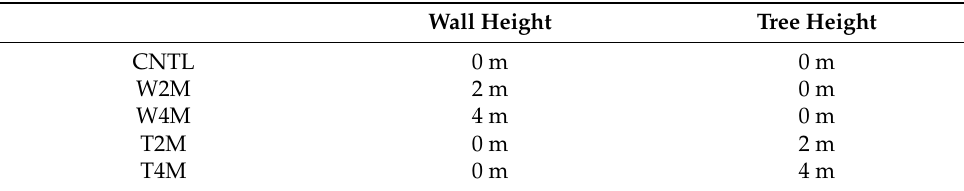
Table 1. Summary of the fence heights considered in this